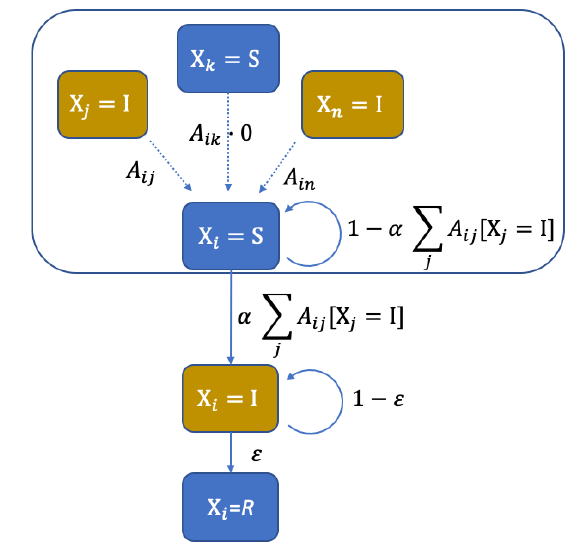
Figure 4. Simple agent-based SIR